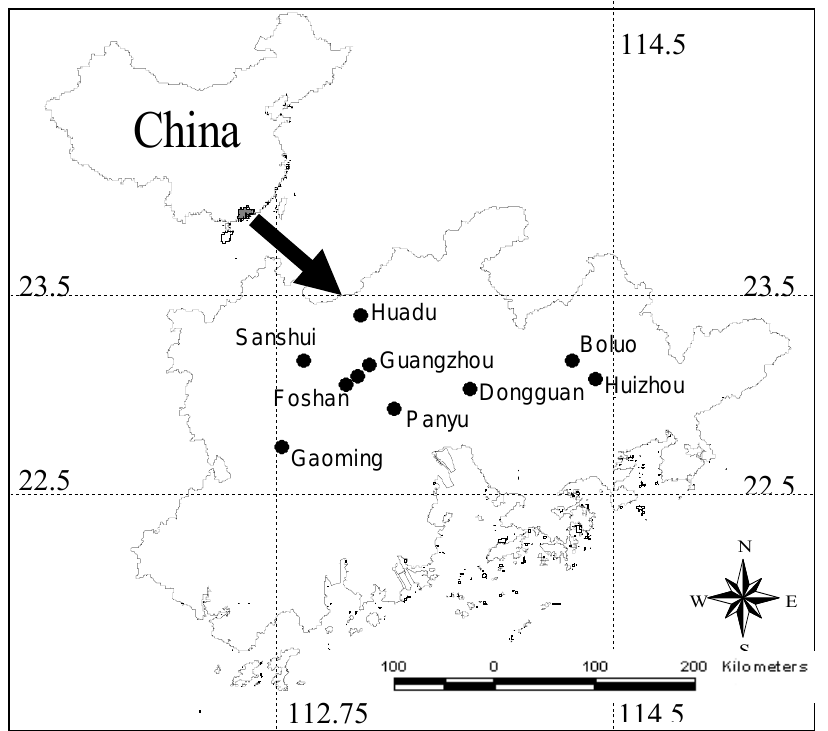
Figure 1. Map of the Pearl River Delta, showing the ten cities selected for the